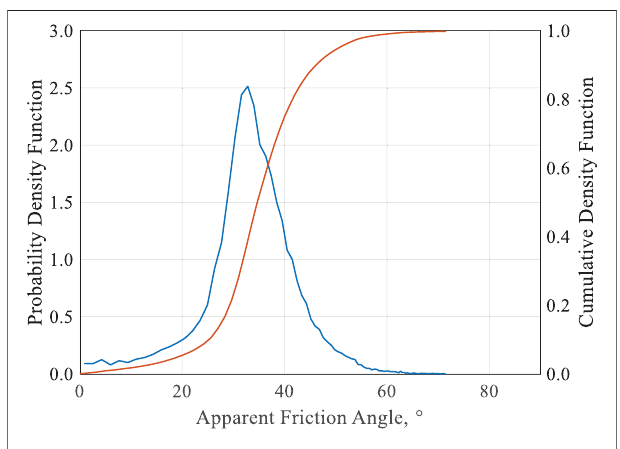
FIGURE 4 | Collected apparent granular friction angle ( θ app ) for all 14 measurement sets in Supplementary Table S1 . The blue line indicates theprobabilitydensityfunction,whiletheorangeshowsthecumulativedensity function.